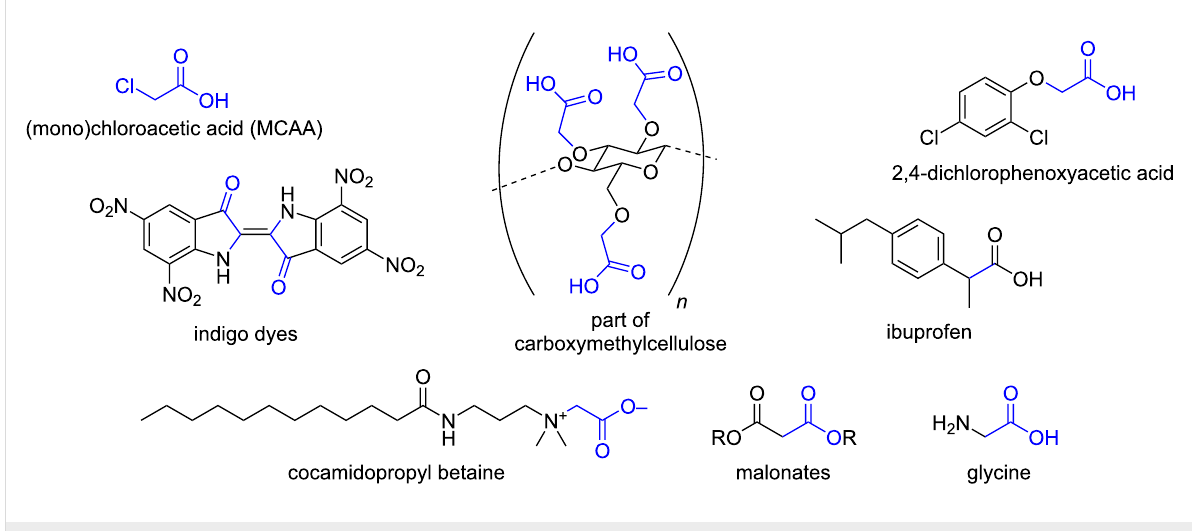
Figure 1: A part of the industry around monochloroacetic acid.